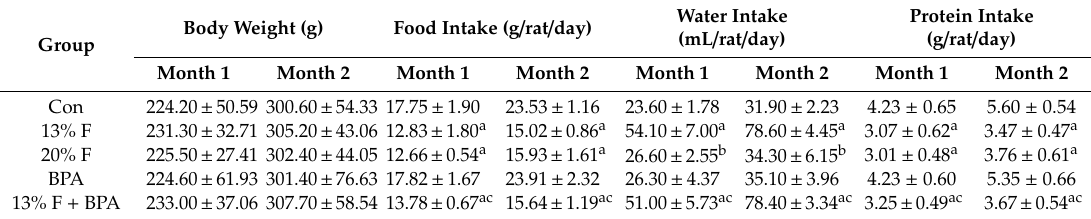
Table 1. The e ff ect of fructose and / or BPA exposure on body weight, and food, water and protein intake in male